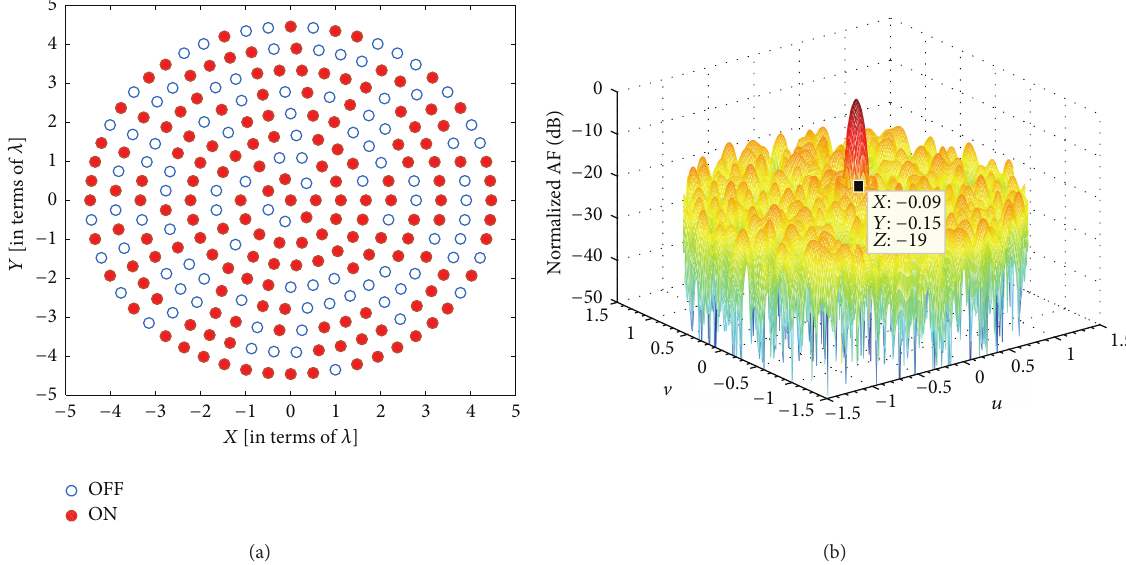
Figure 6: Uniform CCAA optimized by MTLBO for SLL reduction in basically extended space. (a) Configuration of a 156-element uniform array and (b) the related array factor with SLL = − 19.0dB and FNBW =